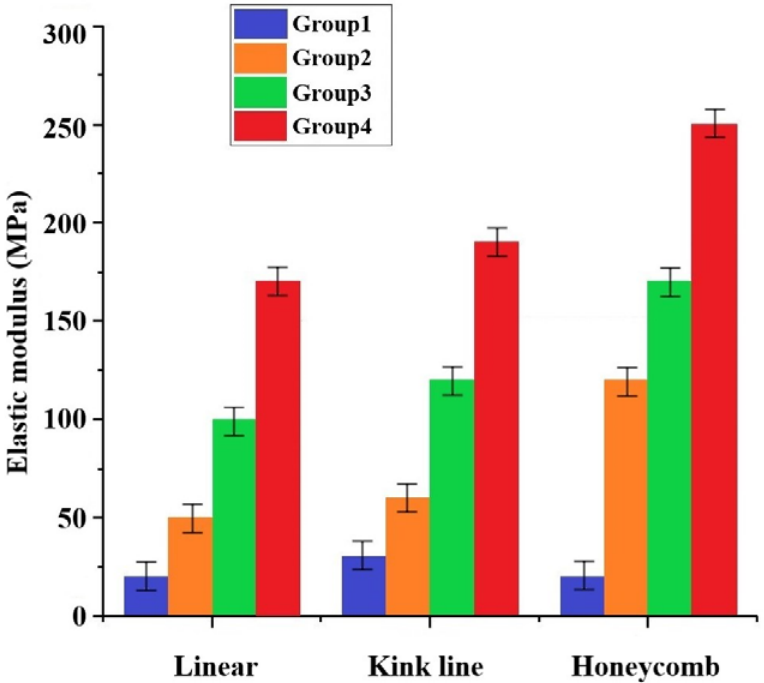
Figure 12. Results of elastic modulus increasing with zirconia for different internal structures.